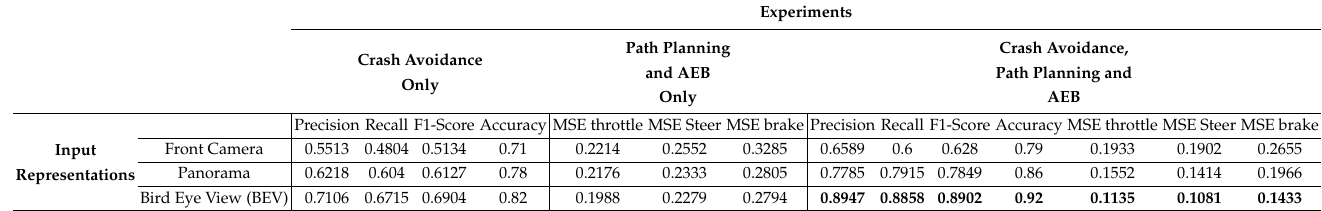
Table 3. Measurement metrics